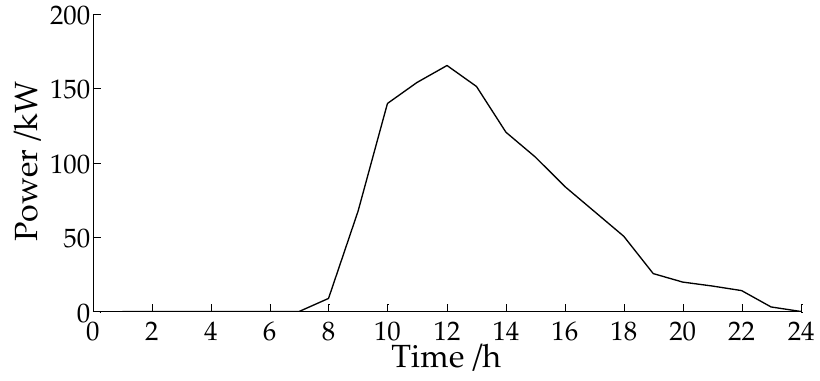
Figure 7. Unconstrained EV charging load.